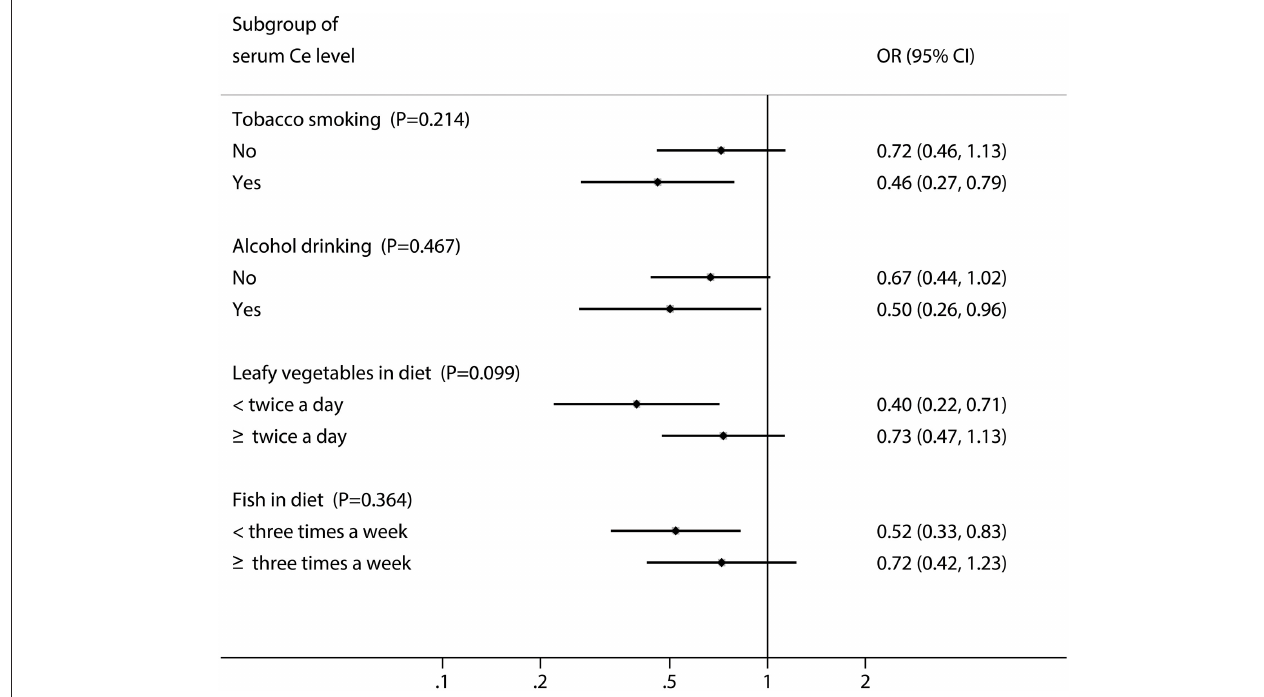
FIGURE 2 | Odds ratios (ORs) and 95% CIs for the serum Ce stratified by environmental factors.